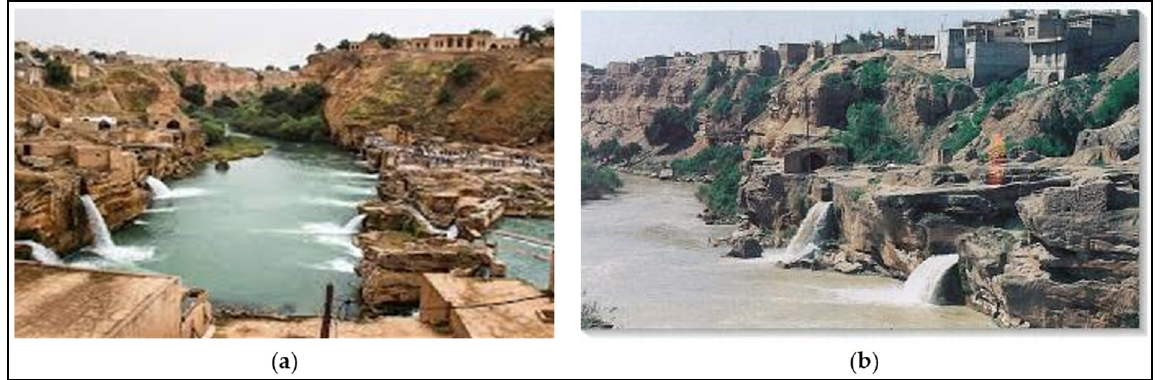
Figure 8. The Shushtar water mills complex: ( a ) general view and ( b ) two 1700-year-old mills (adapted from [31]).